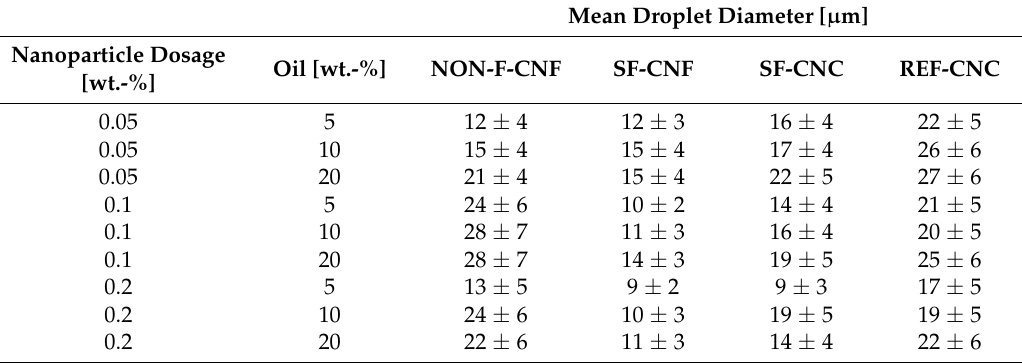
Table 2. Summary of the mean oil-droplet diameters ( µ m) for oil-to-water emulsions with varying nanoparticle concentrations and oil water